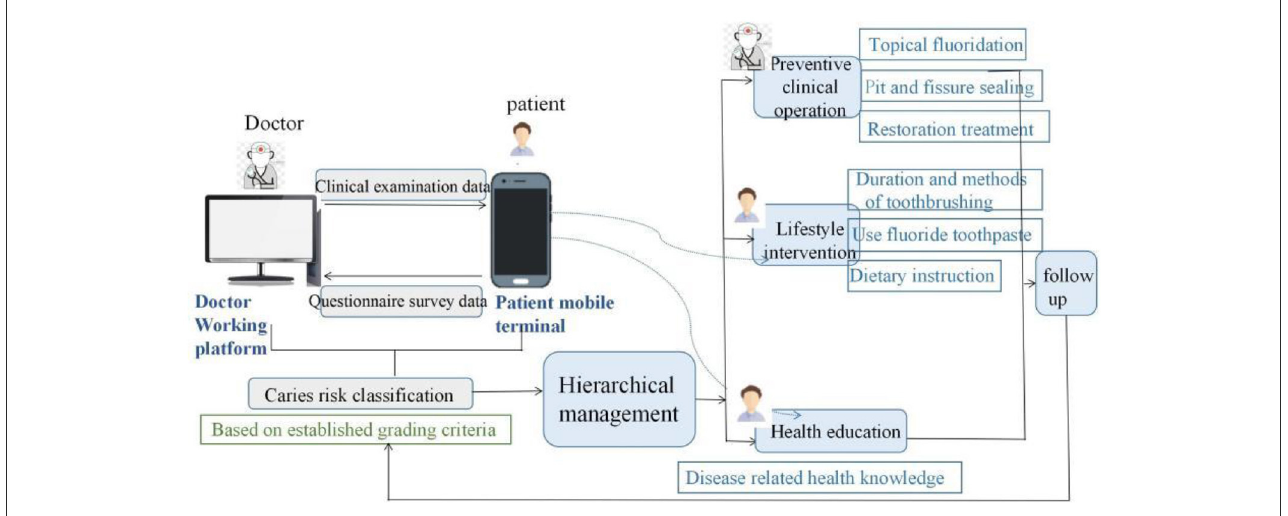
FIGURE2 Schematic diagram of the online intervention process of the experimental